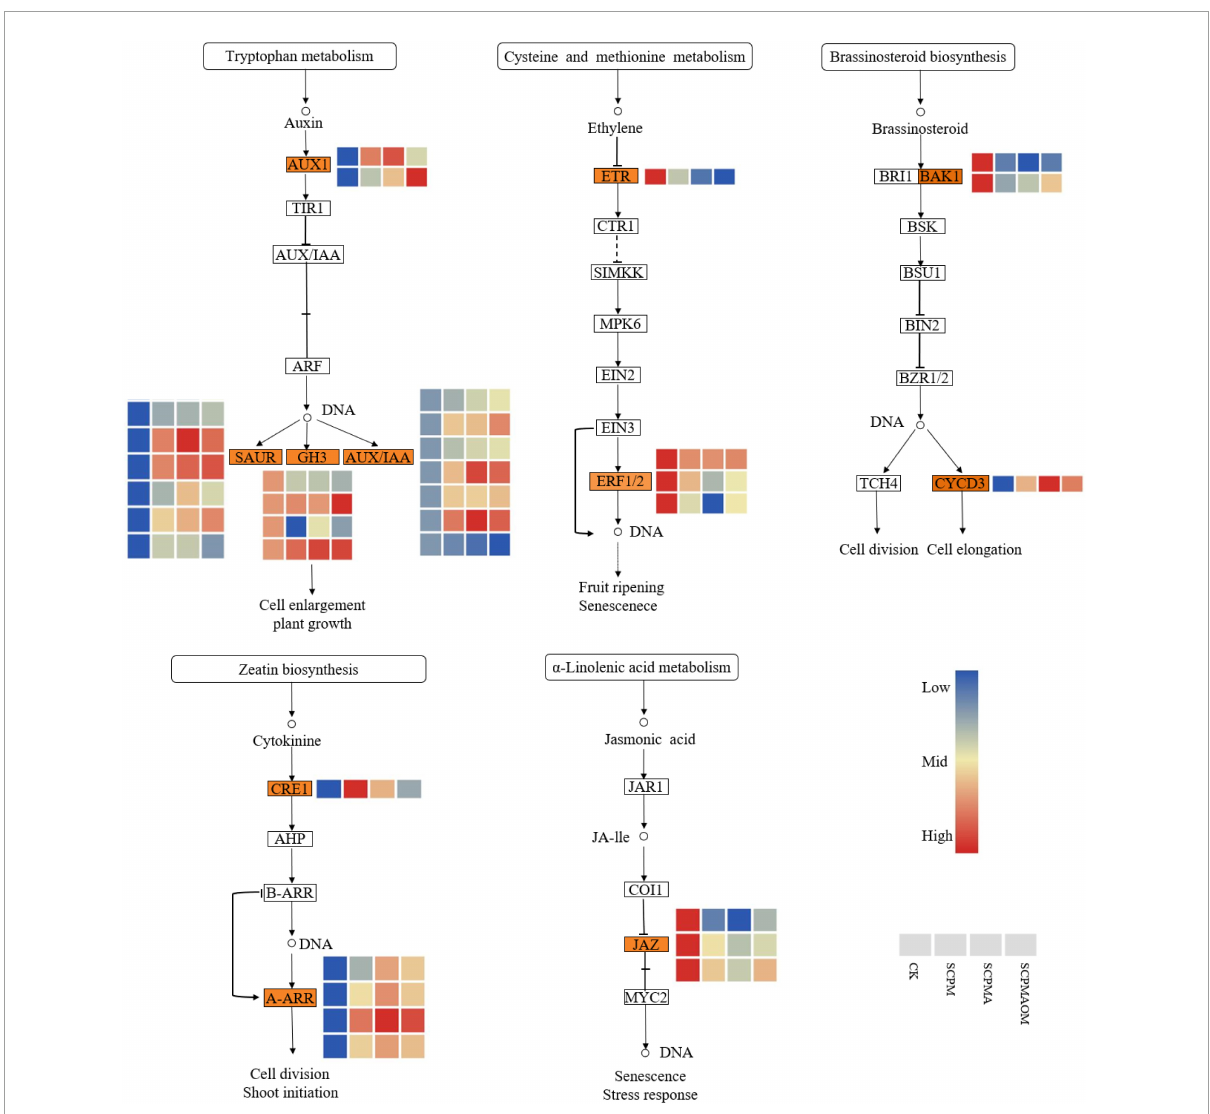
FIGURE5 Heat map of DEGs involved in plant hormone signal transduction pathways. Red color denoted genes with high expression level, while blue color denoted genes with low expression level. The relative expression levels of DEGs were calculated using the log2 ratio.